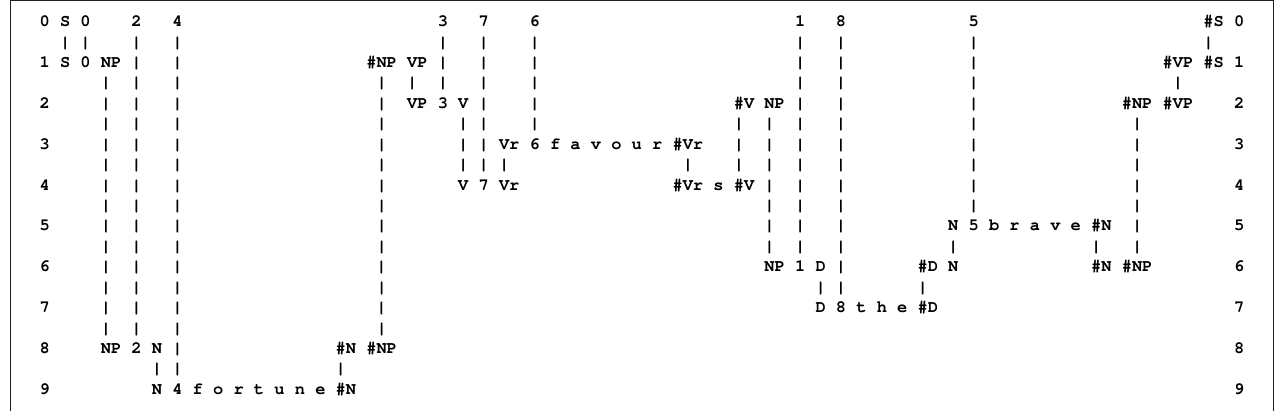
FIGURE 10 | The best multiple alignment produced by the SP computer model with the same Old patterns as for the multiple alignment shown in Figure 2 but with the New pattern comprising an appropriate sequence of ID-symbols, “ S 0 2 4 3 7 6 1 8 5 #S ,” as described in the